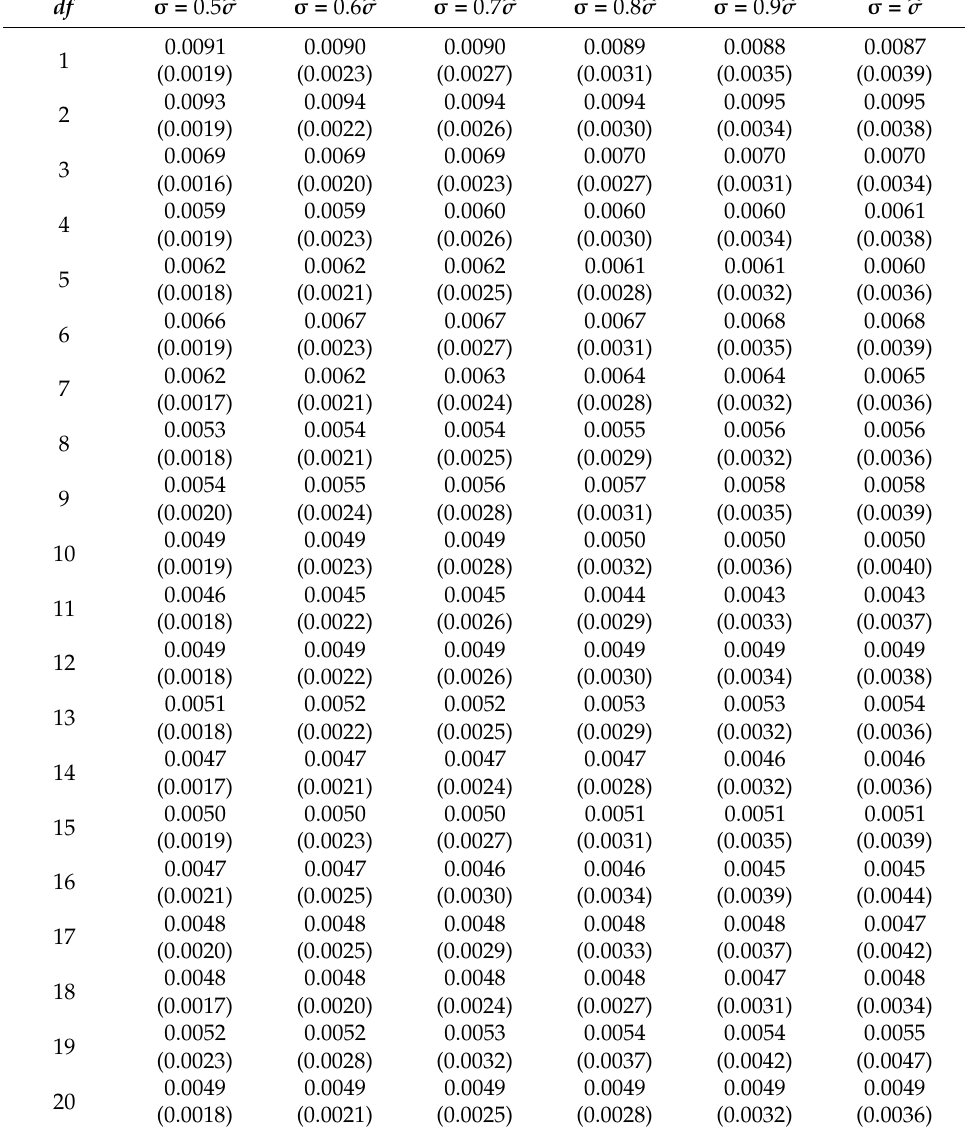
Table 4. Mean (SD) of estimated (cid:98) β 1 s derived from Bayesian